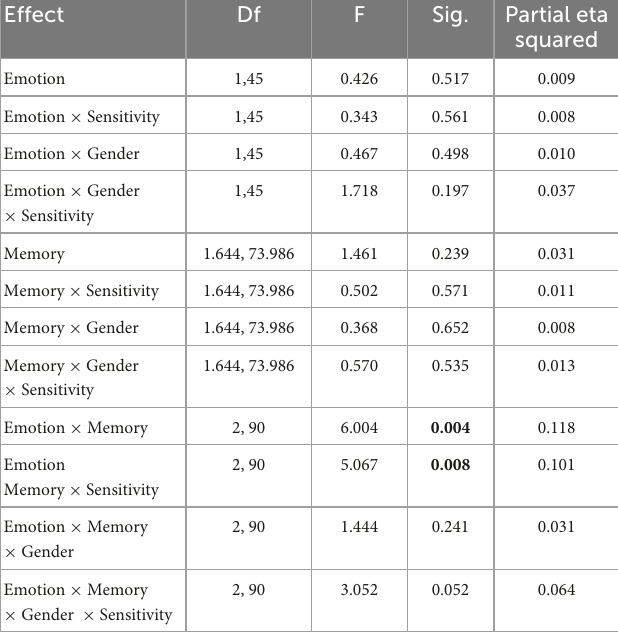
TABLE 2 Within-subject effects of emotion, memory type, and their interactions.